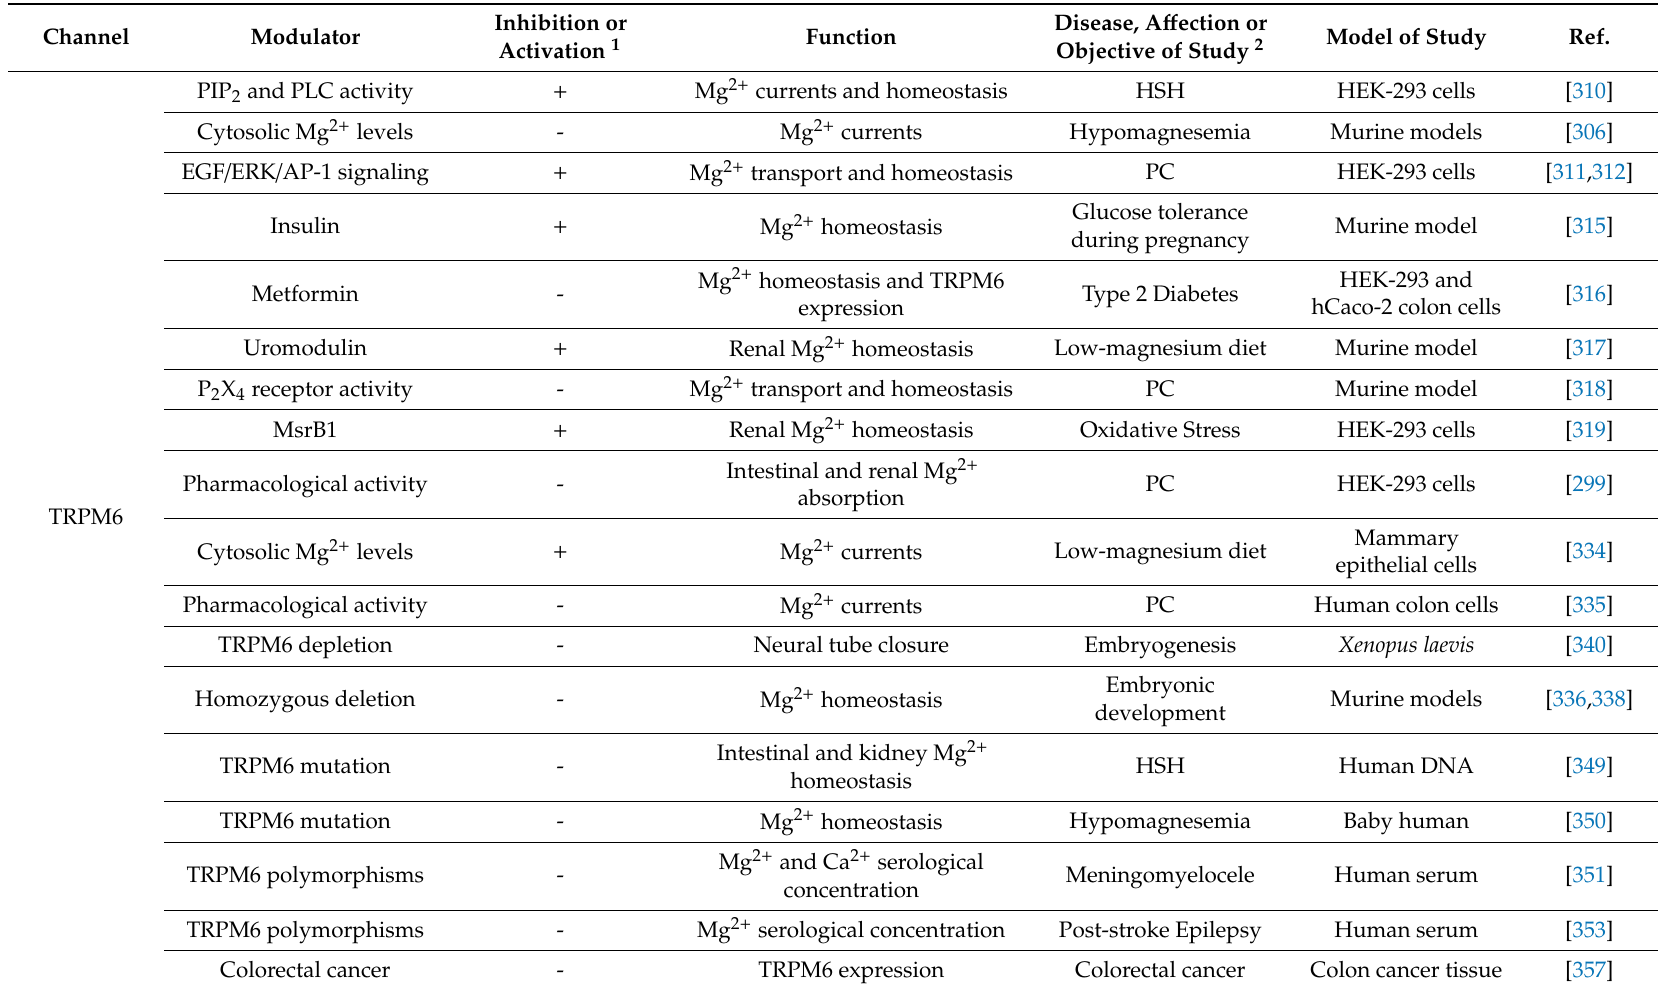
Table 4. Molecules modulating the activity of TRPM6 and TRPM7, participation in physiological processes and